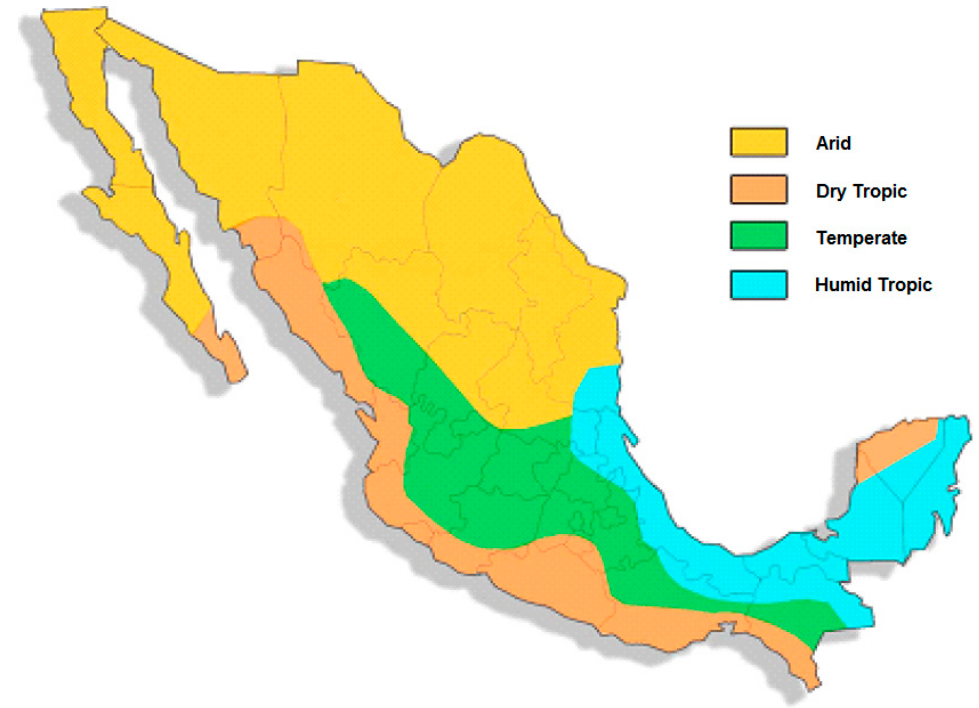
Figure 1. Main climatic regions in Mexico.